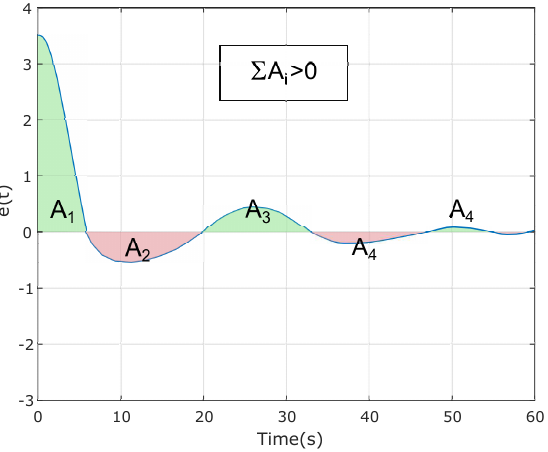
Figure 17. Error of a system formed by a reset controller with a double integrator plant.